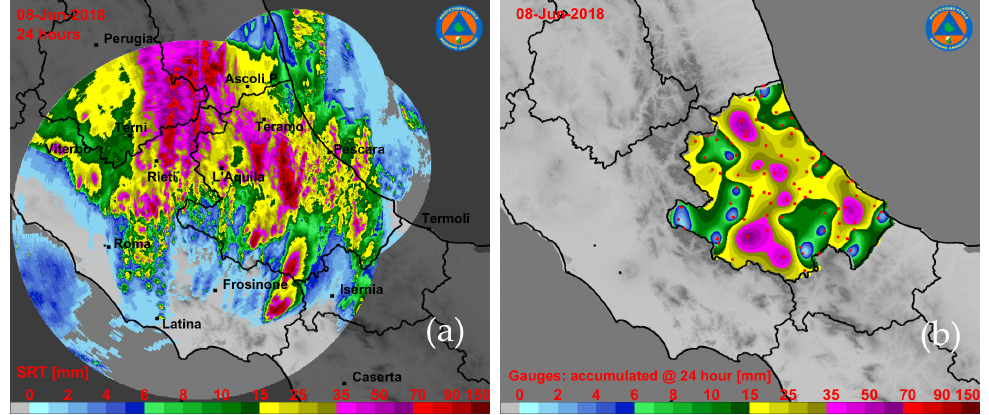
Figure 6. 24-h rainfall accumulated during the event occurring during 8 June, 2018: ( a ) radar composite domain and a ( b ) rain-gauge network within the Abruzzo region (see Figure 1).